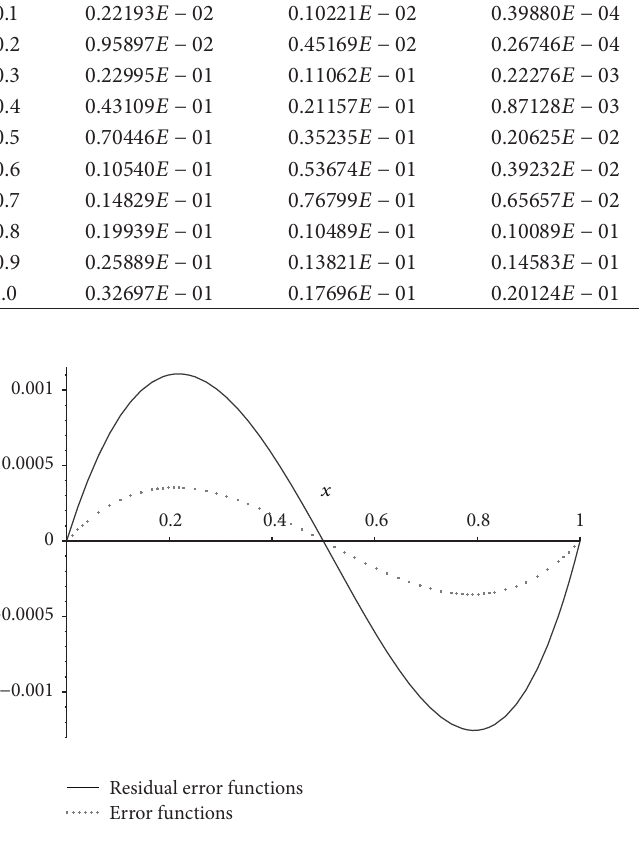
Figure 2: Comparison of error and residual error functions for 𝑦 3,7 values for Example 4.